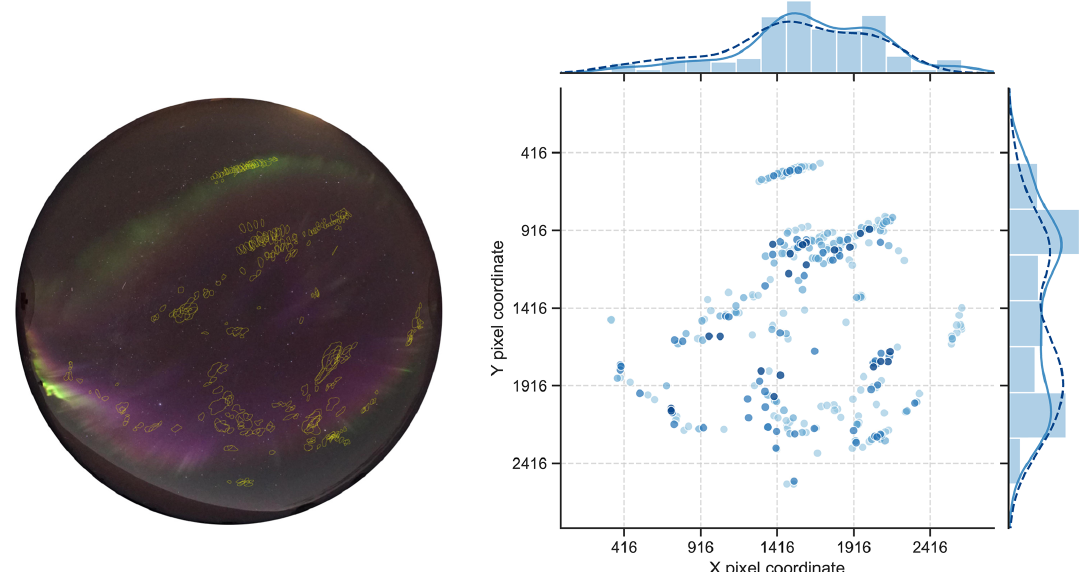
Figure 1. All 262 identified FAE candidates for event 3 on 18 December 2017 (left panel), overlain on the first image of the series taken at 07:36:35UTC. The FAE candidates occurred over a time period of ∼ 50min. Geomagnetic east corresponds to the left-hand side of the image and geomagnetic north to the top. All 305 FAE locations (right panel) are then plotted in horizontal and vertical pixel coordinates, with the corresponding histogram distribution and kernel density estimation (KDE). FAEs are shaded according to confidence groups, with darker shades being FAEs of a higher quality. The dashed KDE line is only calculated for FAEs of groups 1 and 2. Credit: all-sky camera (ASC) image provided by the